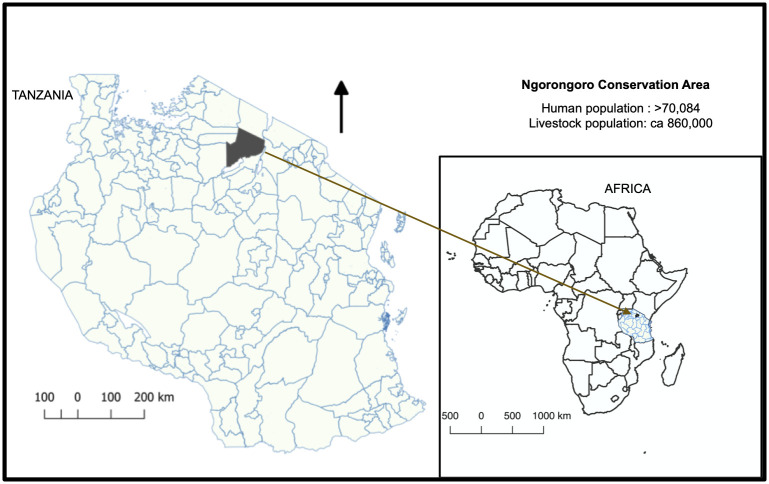
Tanzania, with the study area for evaluating anthrax diagnostic tools, the Ngorongoro Conservation Area (NCA), shown in grey.The NCA is a multiple land use area where people, livestock and wildlife live in close proximity and anthrax is endemic. Map was produced using data from Tanzania Bureau of Statistics.